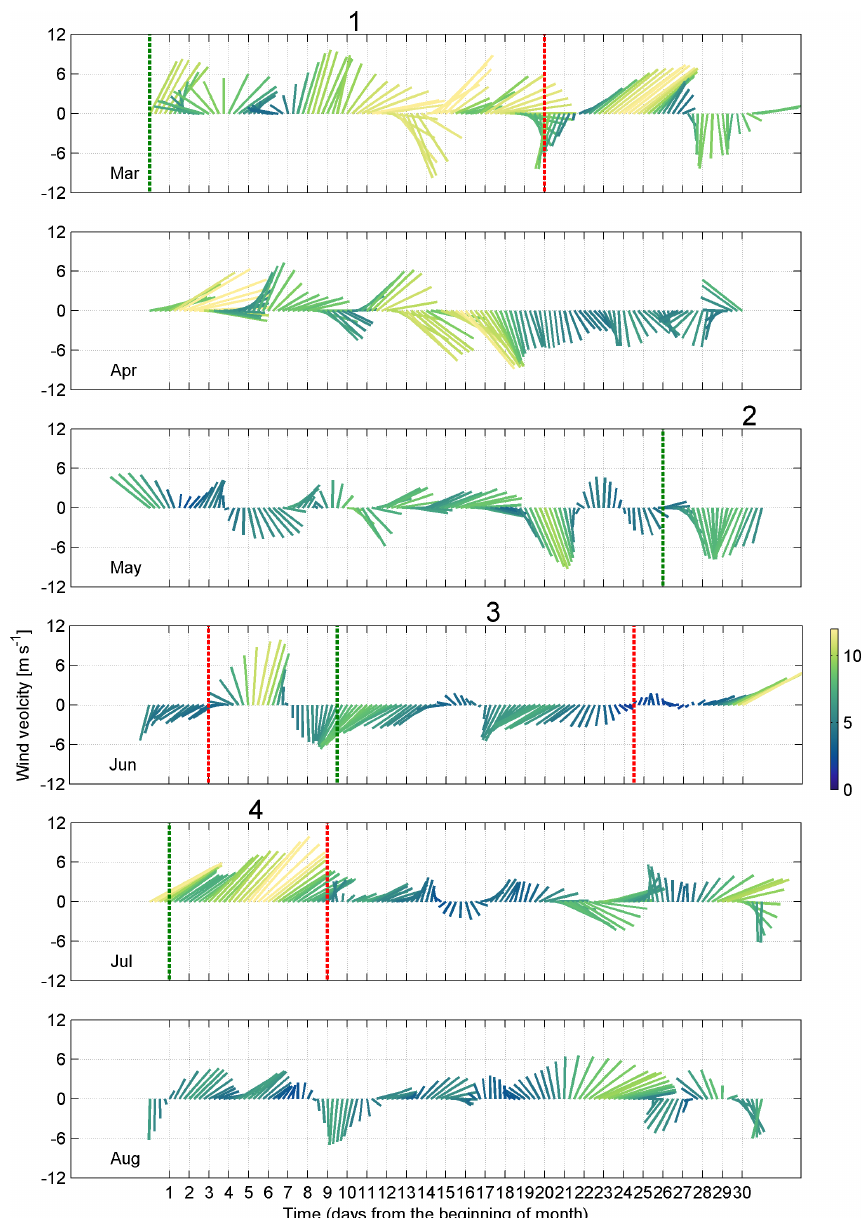
Figure 4. Time series of the 10m level ERA5 wind data from 1 March to 31 August 2020. Four selected periods are shown: (1) prevailing southwesterly wind, 1–21 March; (2 and 3) prevailing northerly wind, 27 May–4 June and 10–25 June; (4) prevailing southwesterly wind, 2–10 July. The green dotted line marks the beginning and the red dashed line marks the end of the period. Wind data were smoothed with a 36h filter. The color scale shows wind speed in meters per second (ms − 1